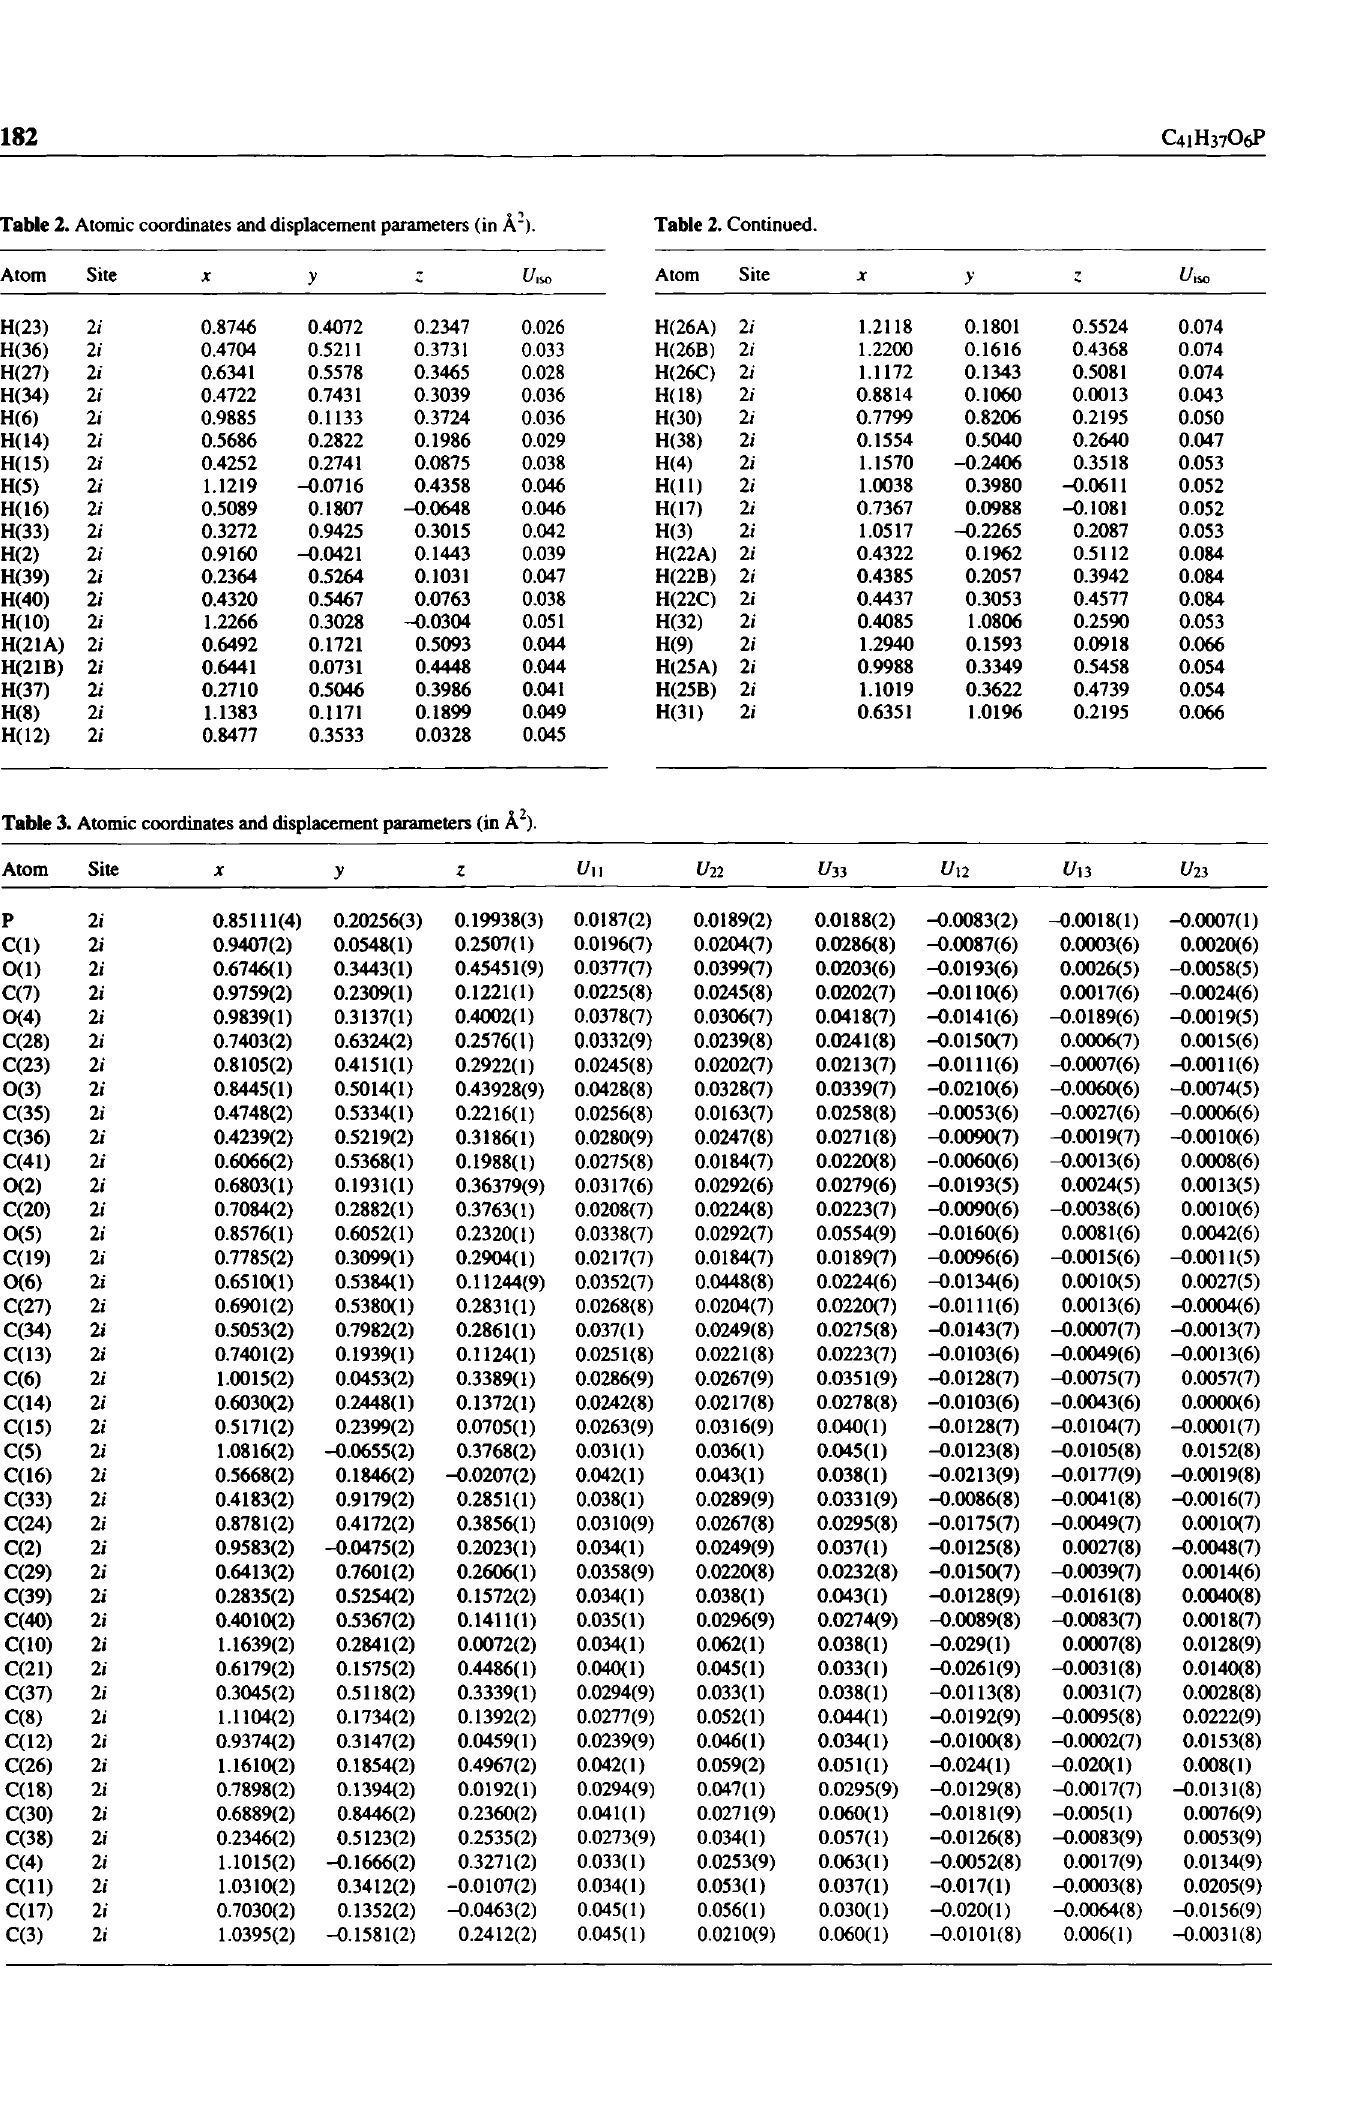
Table 3. Atomic coordinates and displacement parameters (in A 2